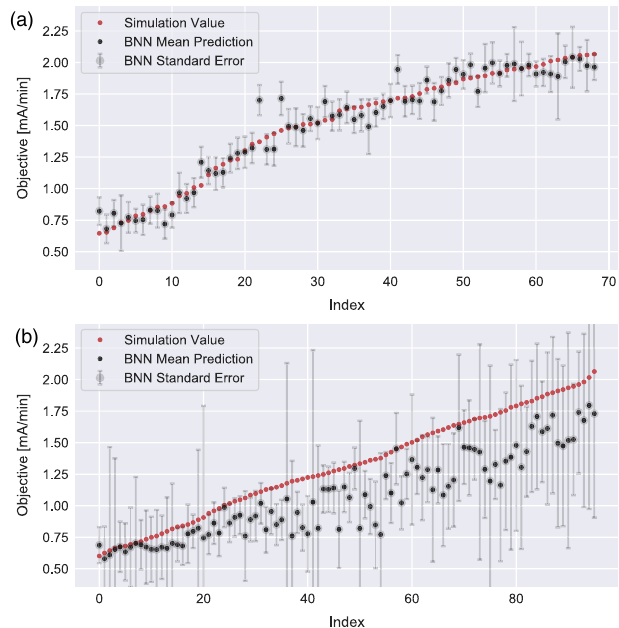
FIG. 11. Schematic for the encoder-decoder architecture for the LCLS-II injector longitudinal phase space image